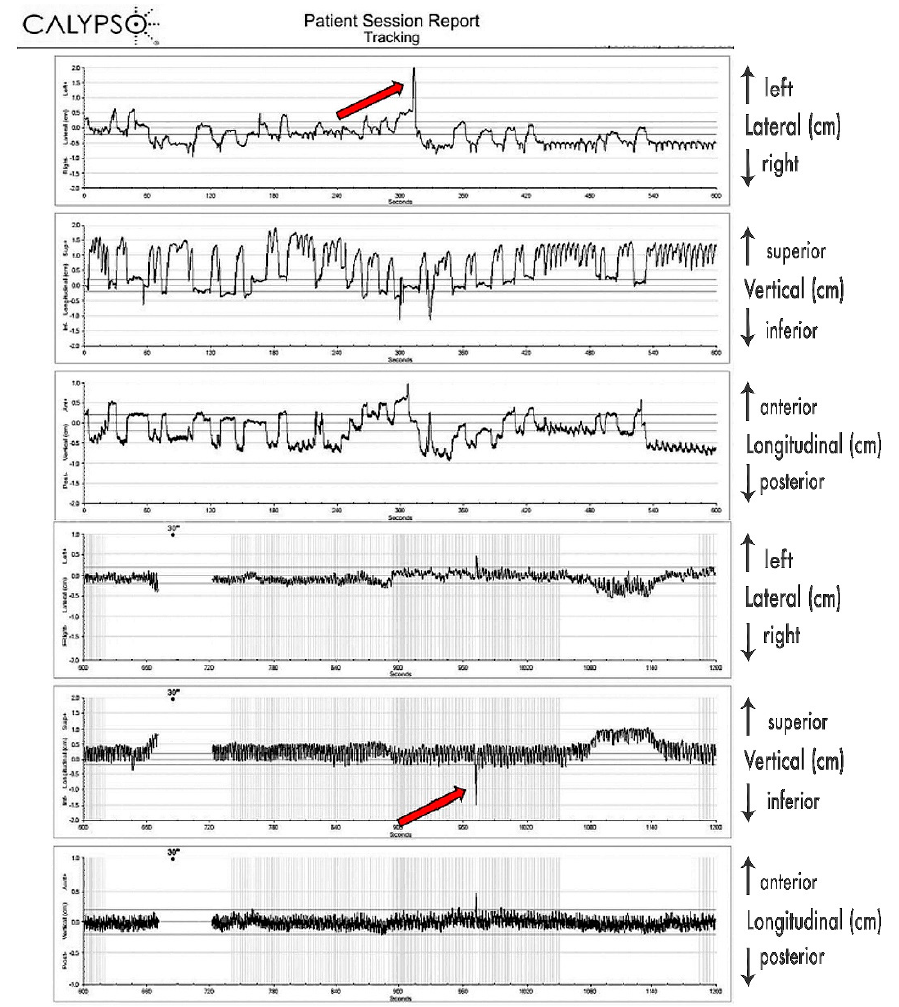
Figure 3. The typical Calypso ® “Patient Session Report” form, with the graphical presentation of the recorded fiducial excursions in the lateral, vertical and longitudinal axes, during one fraction. The isolated, short-lasting movements of the tumor on the graphical presentation are marked using red arrows.